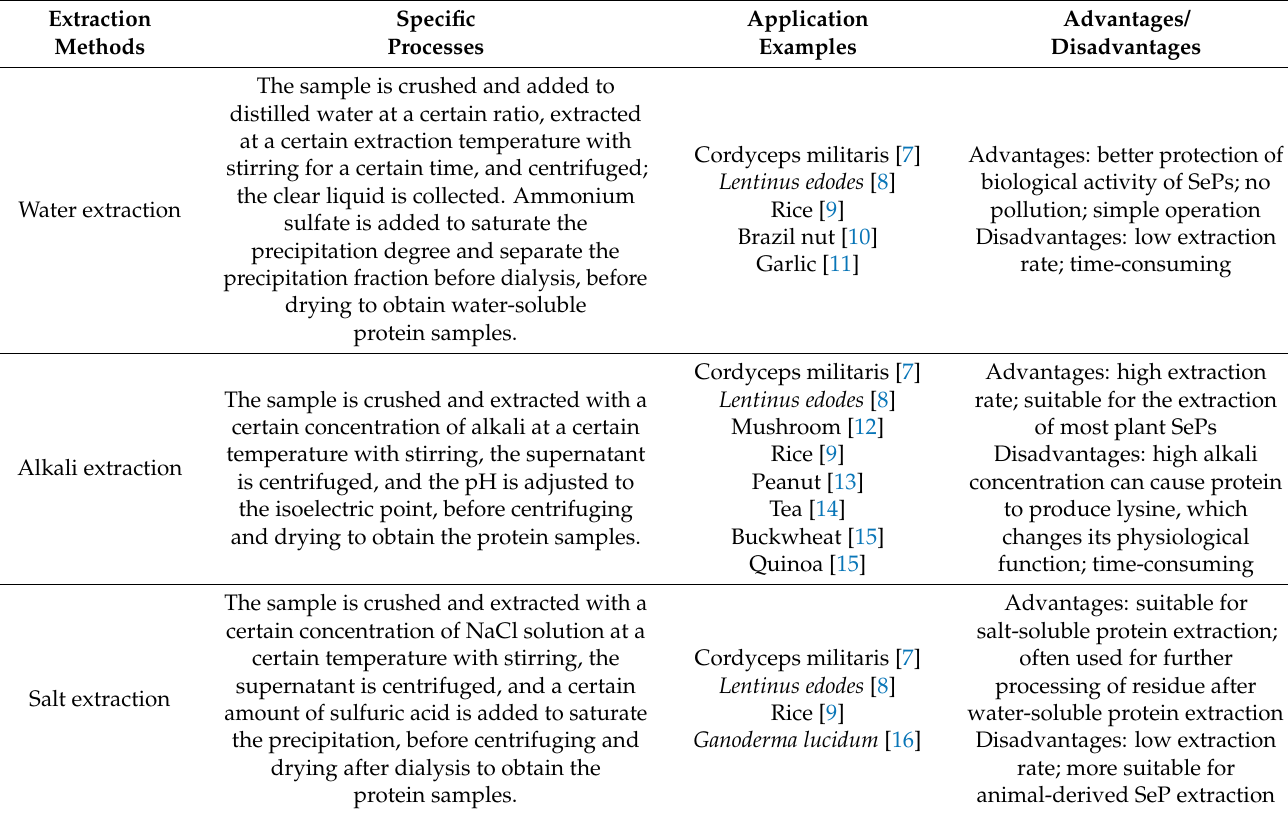
Table 1. Liquid-phase extraction method of plant Se-enriched